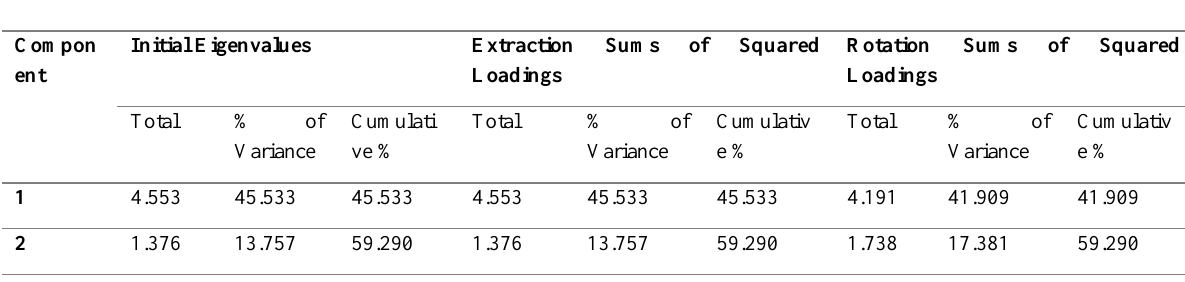
Table 6: Factor loading for information needs